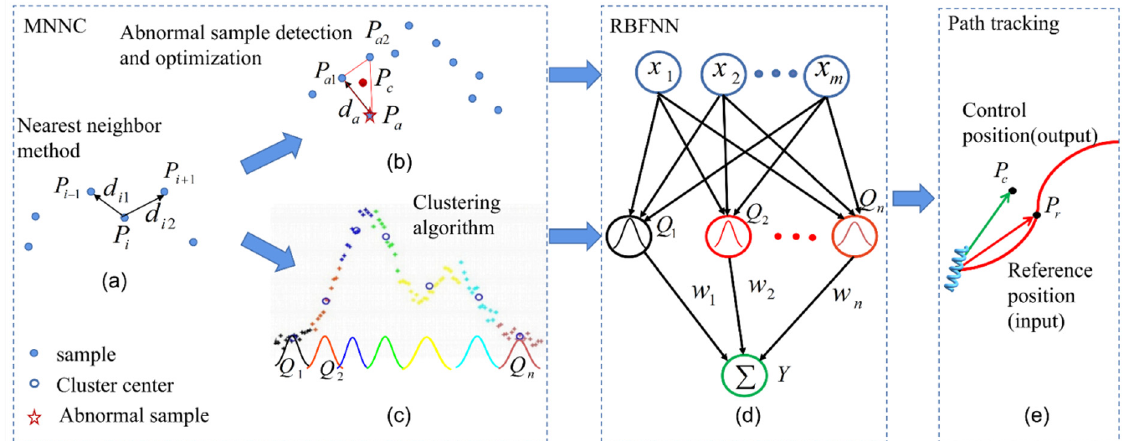
Figure 1. Concept of an RBFNN algorithm based on MNNC for path tracking: ( a ) calculation of the distance to obtain the nearest neighbor; ( b ) detection of the abnormal samples based on nearest neighbor method; ( c ) clustering of the samples based on the nearest neighbor; ( d ) construction of the RBFNN based on MNNC; ( e ) obtaining the reference position by the MNNC-based RBFNN in the path tracking system.